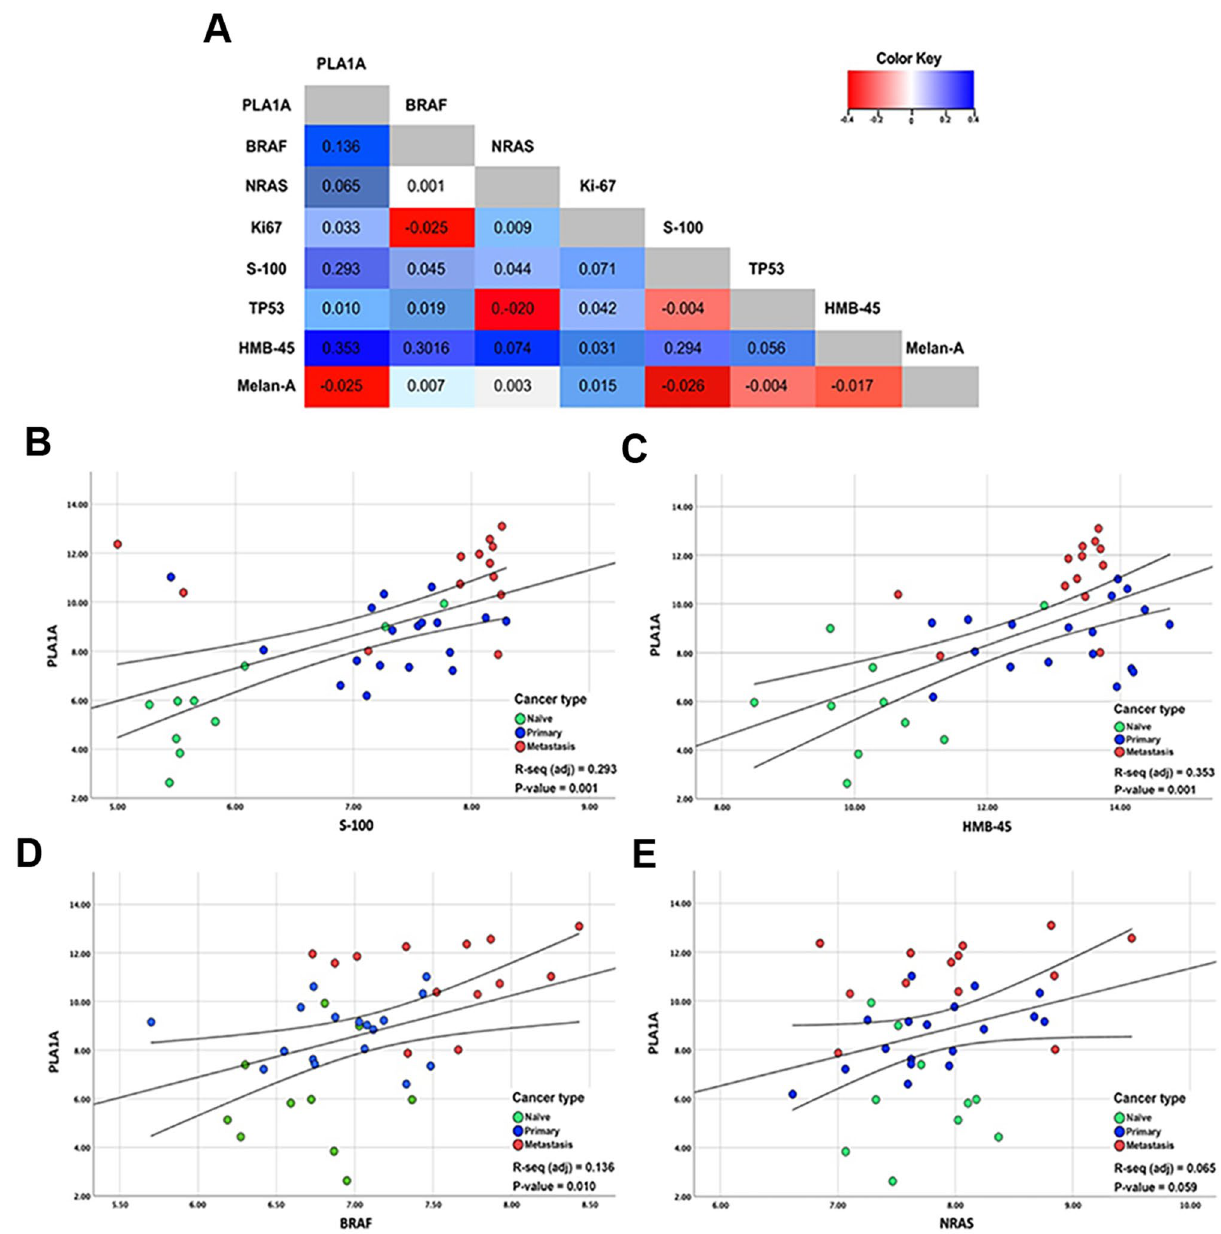
Figure 2. Correlation coefficient of PLA1A with diagnostic markers across metastatic melanoma. ( A ) Linear logistic regression analysis to predict the accuracy of PLA1A expression in comparison to the routine diagnostic markers of malignant melanoma. By considering both mRNA and serum levels, PLA1A was found as correlated to the expression of S-100 ( B ), HMB-45 ( B ), BRAF ( C ), and NRAS ( E ) in naïve/normal melanoma (green cycle), primary melanoma (blue cycle) and metastasis melanoma (red